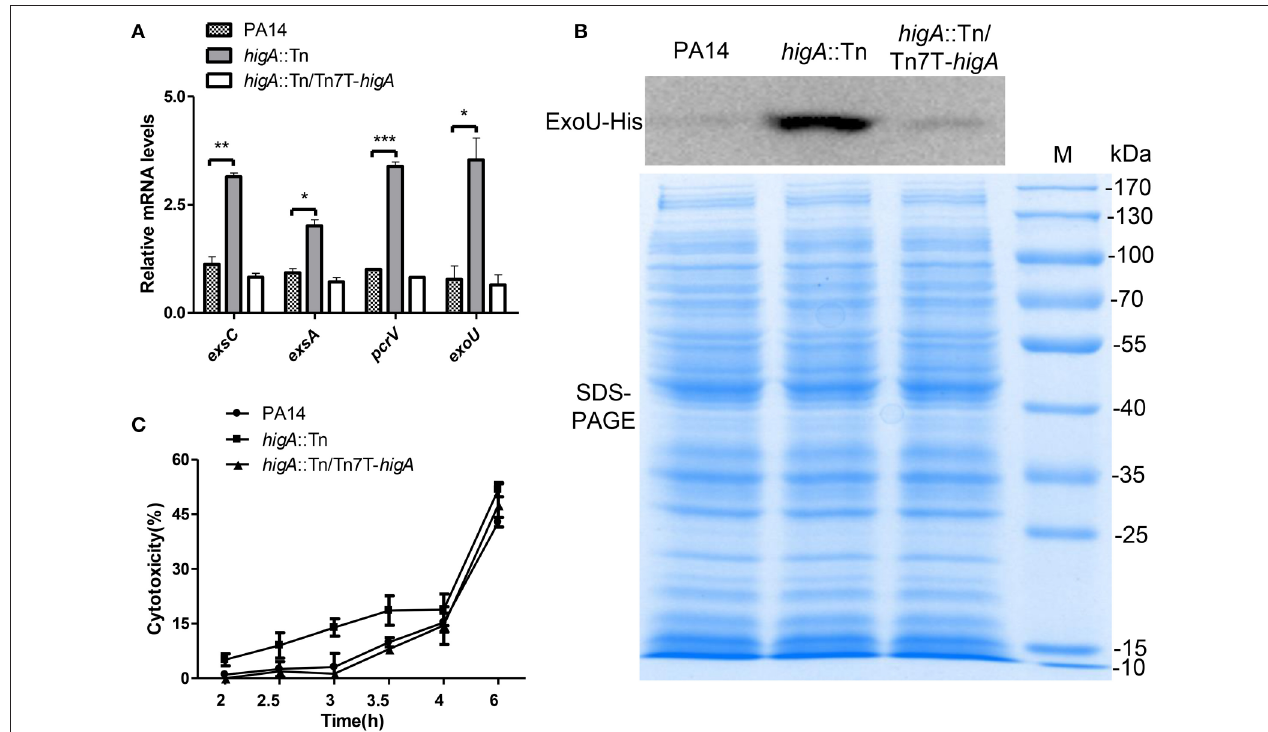
FIGURE 3 | Expression levels of T3SS genes in wild type PA14, the higA ::Tn mutant and complemented strain. (A) Relative mRNA levels of exsC , exsA , pcrV, and exoU in indicated strains at exponential growth phase (OD 600 = 0.8 ∼ 1.0). Error bars represent the standard errors. * p < 0.05, ** p < 0.01, *** p < 0.005 compared to wild type PA14 by Student’s t -test. (B) Bacteria carrying an exoU -His driven by its native promoter (P exoU -exoU -His) were grown in LB at 37 ◦ C. At the OD 600 of 1.0, bacteria were collected. Samples from equivalent bacterial cells were loaded into SDS-PAGE gels and stained with Coomassie blue or probed with an anti-His antibody. (C) Raw264.7 cell were infected by indicated strains at an MOI of 10. At indicated time points, the relative cytotoxicity was determined by the LDH release